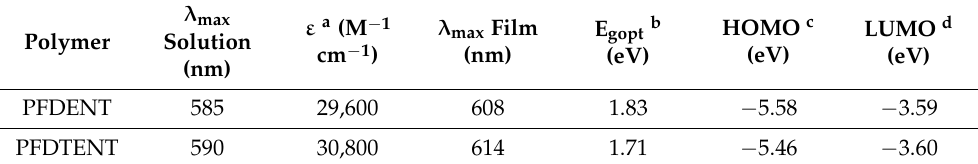
Table 2. A summary of absorption in solution and in films and HOMO and LUMO levels of the